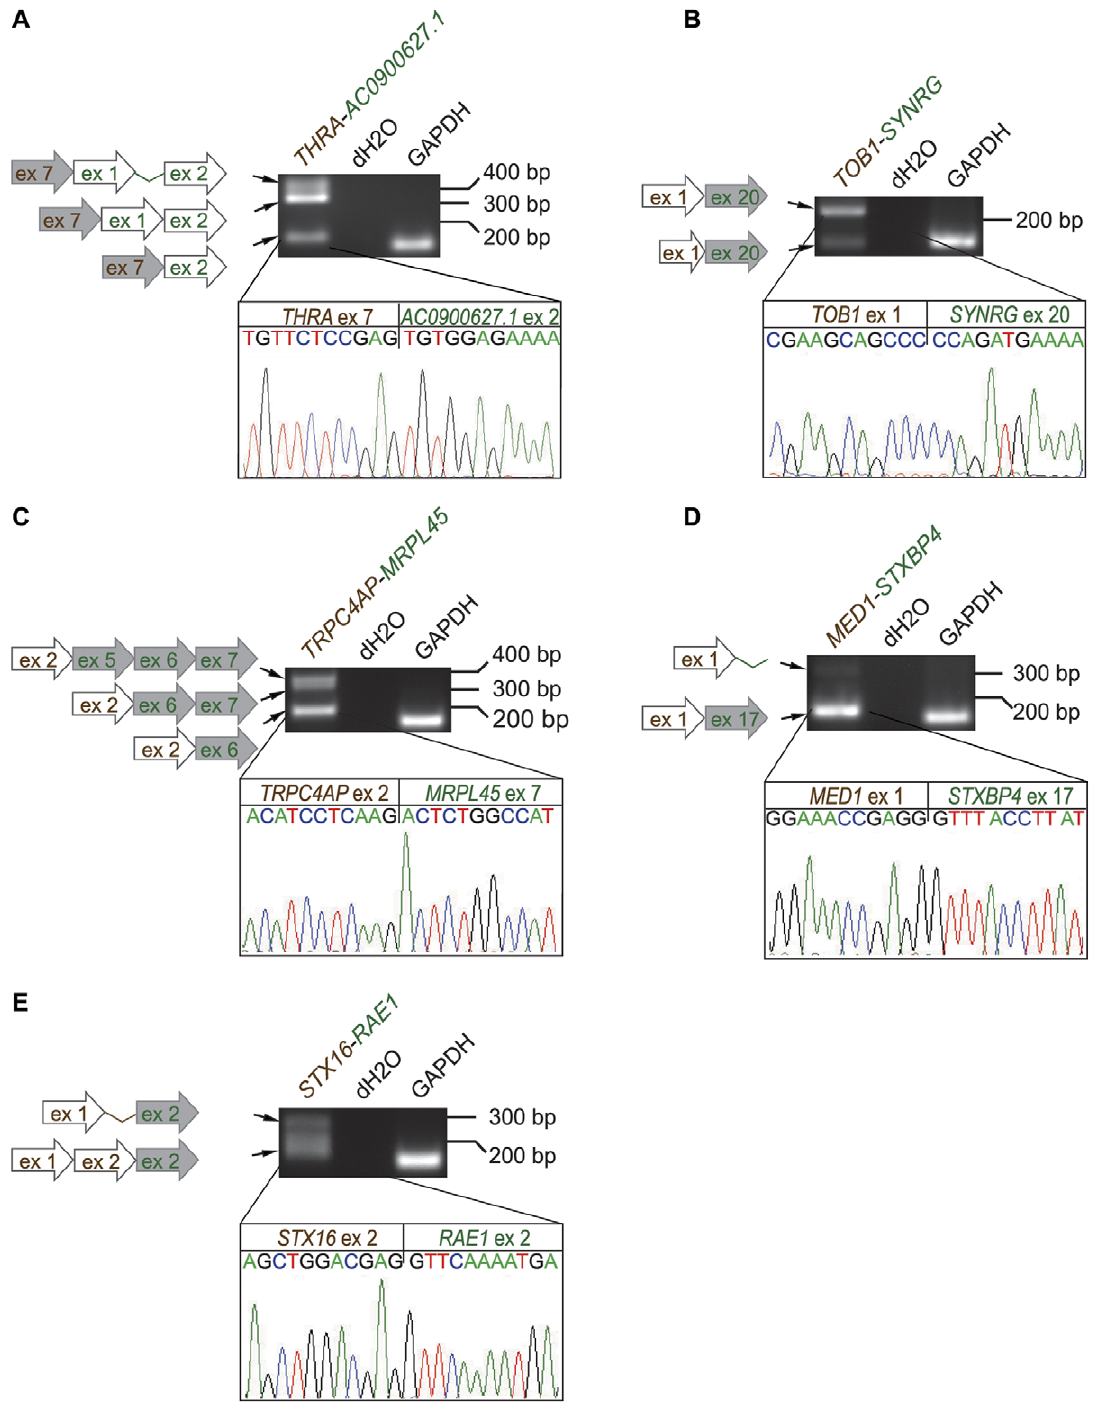
Figure 5. Several fusion transcripts have multiple splice variants. Five examples from BT-474 (A. THRA-AC090067.1 , B. TOB1-SYNRG , C. TRPC4AP-MRPL45, D. MED1-STXBP4 and E. STX16-RAE1 ) are presented. Multiple splice variants are visible as RT-PCR bands, and schematically represented by the arrows to the left. Chromatograms show the actual cDNA sequence break points of the main predicted fusion isoforms, and are connected with lines to the corresponding RT-PCR bands. Gray arrows = coding sequence, white arrows = untranslated exon or 3 9 /5 9 UTR, thin lines connecting exons = intronic regions. 5 9 partner genes are represented by brown color, 3 9 partner genes by green.